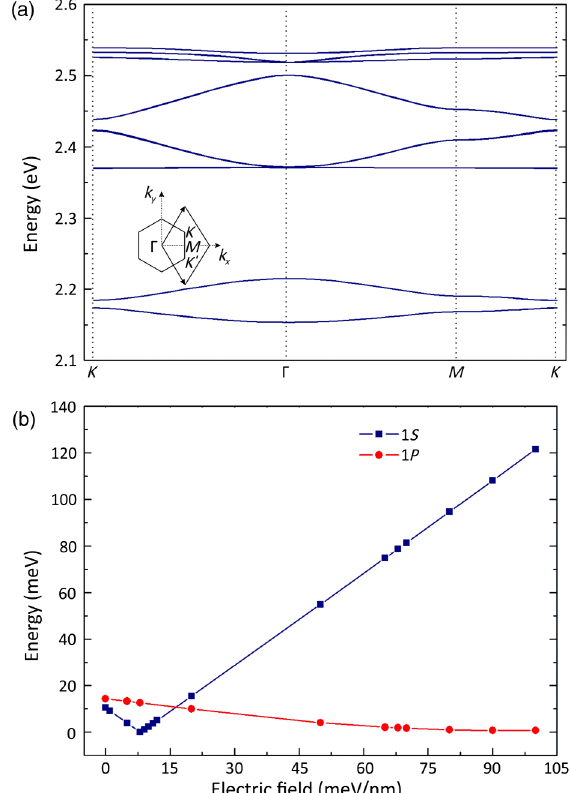
FIG. 8 (color online). (a) Lowest conduction bands of a silicene-type honeycomb lattice of truncated nanocubes of CdSe (body diagonal of 5.27 nm). (b) Evolution of the gap at K between the 1 S (blue squares) and between the 1 P (red circles) Dirac bands versus the electric field strength applied perpendicular to the honeycomb